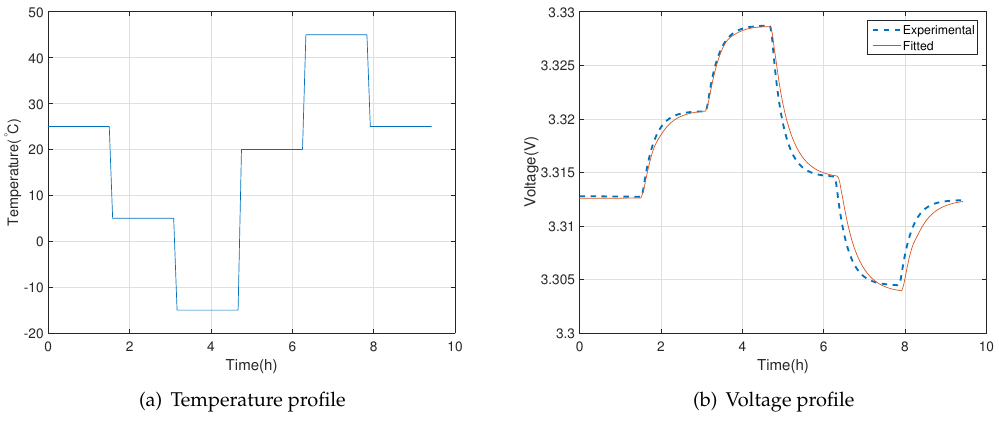
Figure 6. Temperature and voltage profiles for ∂ U / ∂ T estimation at SOC =